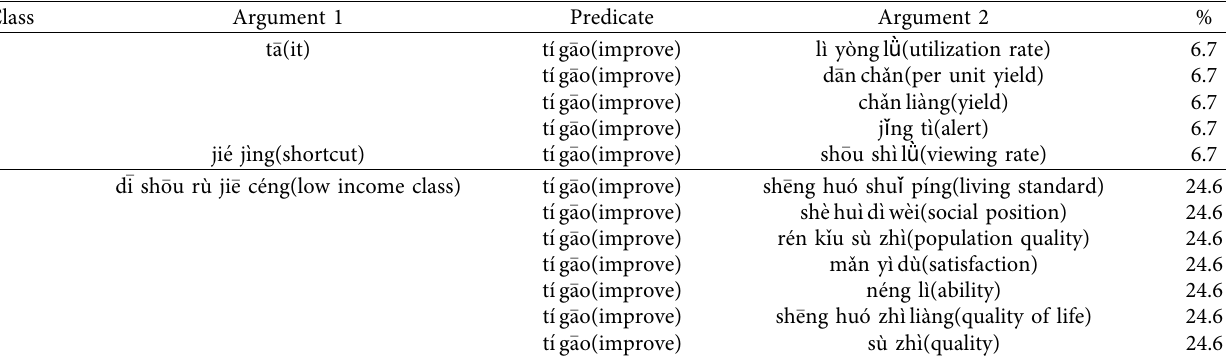
Table 4: Predication structures.